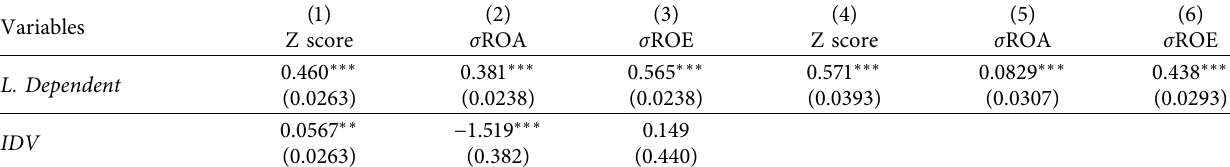
Table 4: Regression results for the impact of diversification on bank stability and